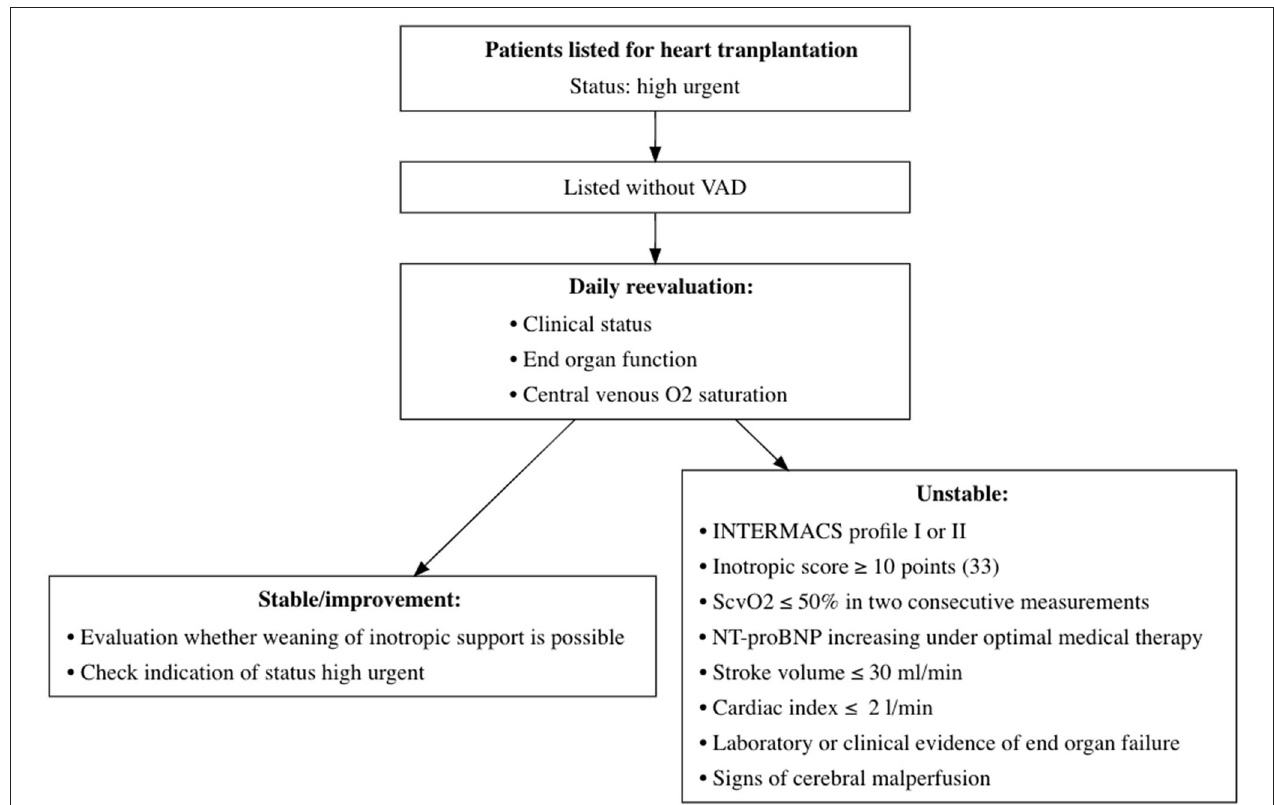
FIGURE 2 | Monitoring structure during waiting time for heart transplantation at the German Heart Center Berlin. Monitoring structure for daily evaluation of patients awaiting heart transplantation in HU status. VAD, ventricular assist device; O 2 , oxygen; INTERMACS, Interagency Registry for Mechanically Assisted Circulatory Support; ScvO 2 , central venous oxygen saturation; NT-proBNP, N-Terminal Pro-B-Type Natriuretic Peptide; HU, high